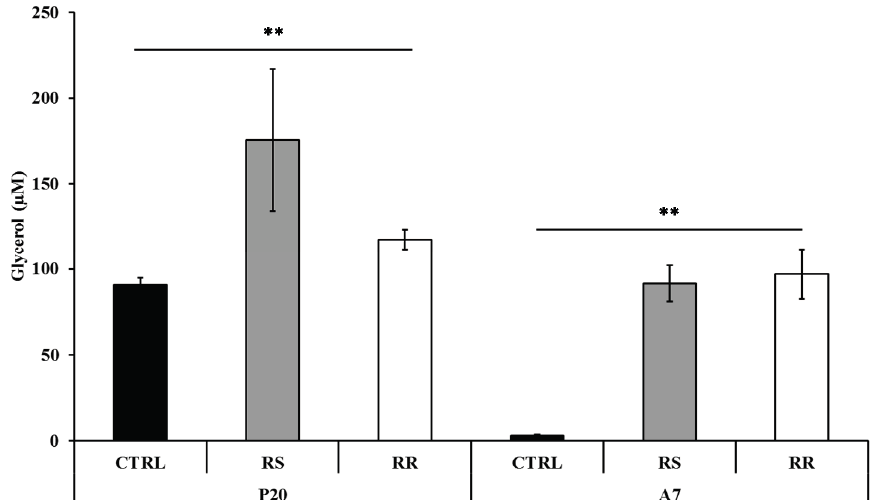
Figure 2. Determination of glycerol release in differentiating (P20) and mature (A7) adipocytes after incubation with RS and RR extracts where glycerol content is given in μ M. Results are depicted as mean ± standard deviation (SD). Asterisks ** indicate the significant difference between treatments for p <